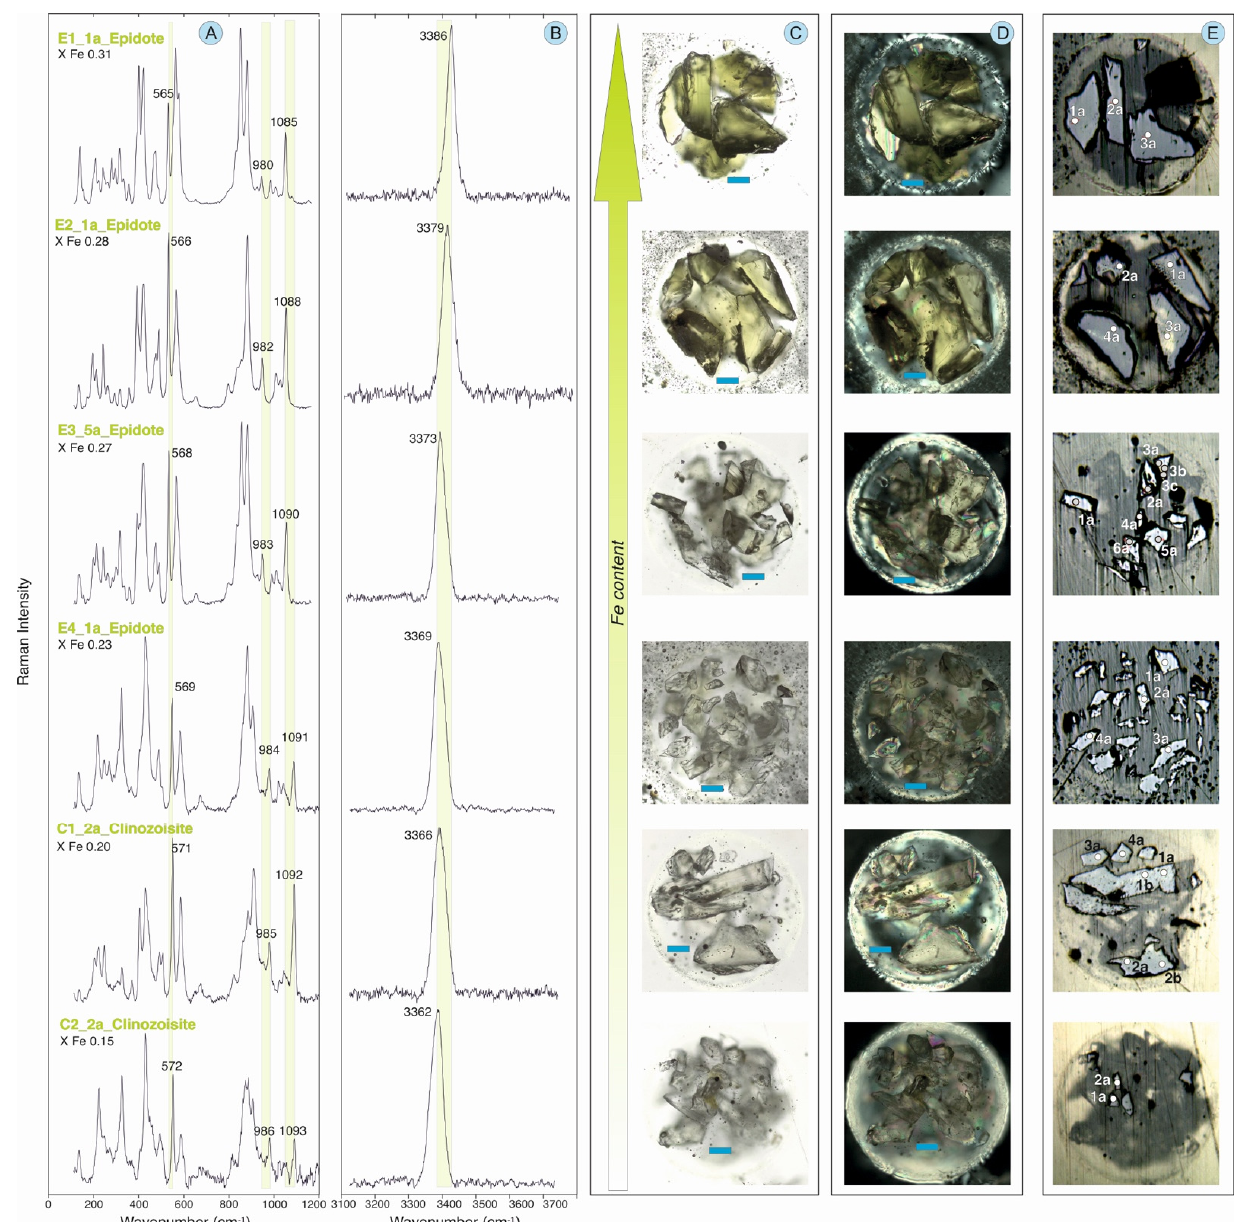
Figure 3. Characterization of epidote and clinozoisite standards. Diagnostic Raman peaks in the low-frequency ( A ) and high-frequency OH ( B ) regions. ( C ) Increase in pleochroism with increasing iron content. ( D ) Increase in birefringence with increasing iron content. ( E ) Maps of analyzed points. Blue bar for scale = 100 µm.